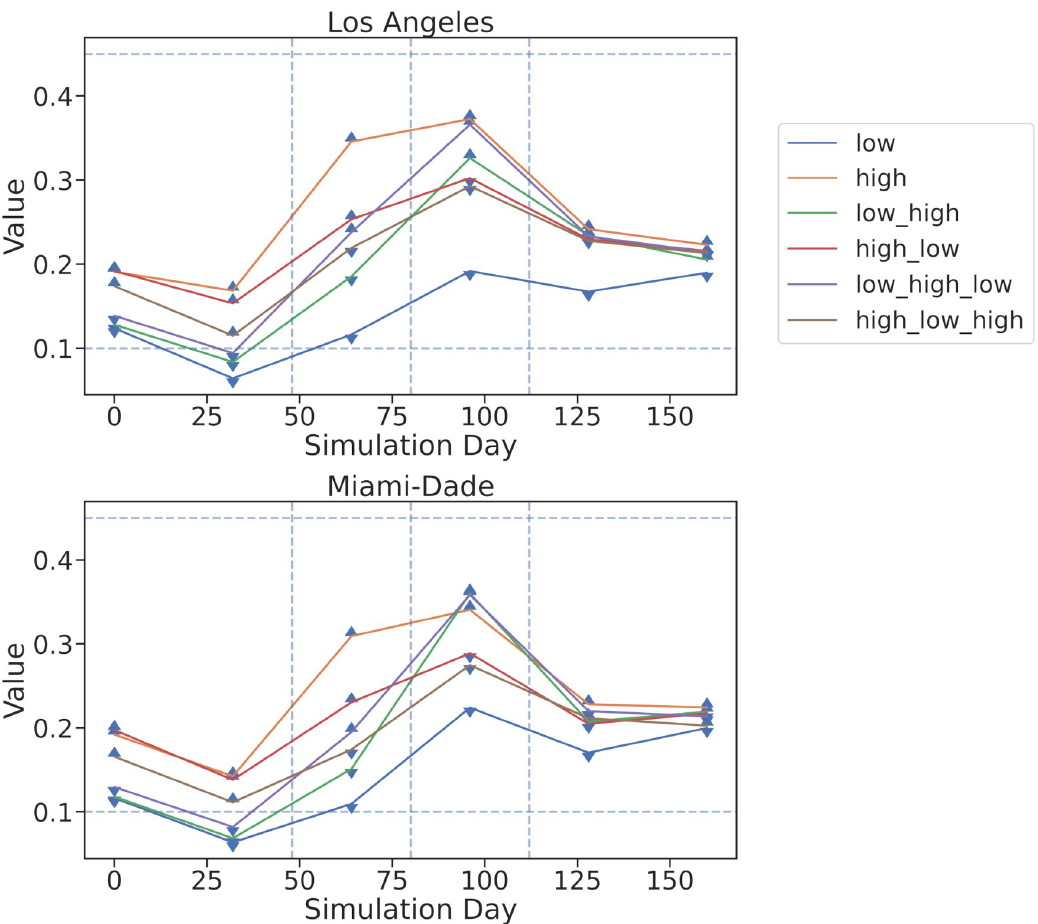
Fig 3. Inferred parameter values from synthetic data. We plot the inferred values of b E across 6 different generated scenarios t using 6 lines. The scenarios are “high”, “high-low”, “high-low-high”, “low-high”, “low-high -low”, and “low” where β E varies temporally between “high” β E = 0.45 and “low” β E = 0.1 states, represented by horizontal dotted lines. The vertical dotted lines represents the times when the true parameters were changed while generating data. The value of β used when generating the data is indicated by marker with up arrows indicating high and down arrows indicating low. We see that when the high value for β was used to generate data, the inferred value was higher and similarly the inferred value was low when the generating value was low. The inferred value for β E is closer to the prior value of 0.2 in all scenarios at the end of the simulation when the signal from the cumulative infection counts is weaker.